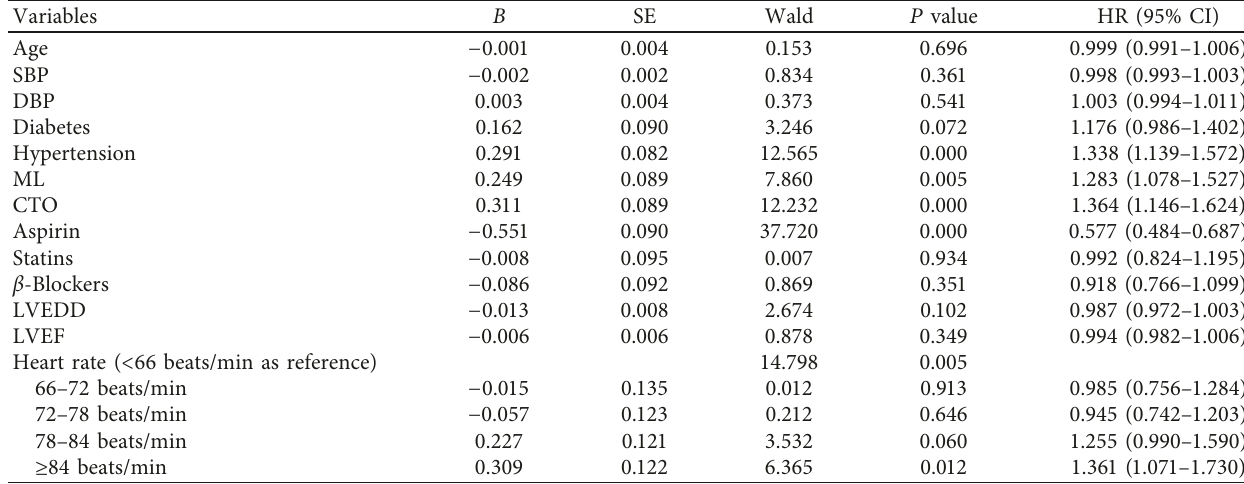
Table 5: Multivariable Cox regression analysis of MACEs.